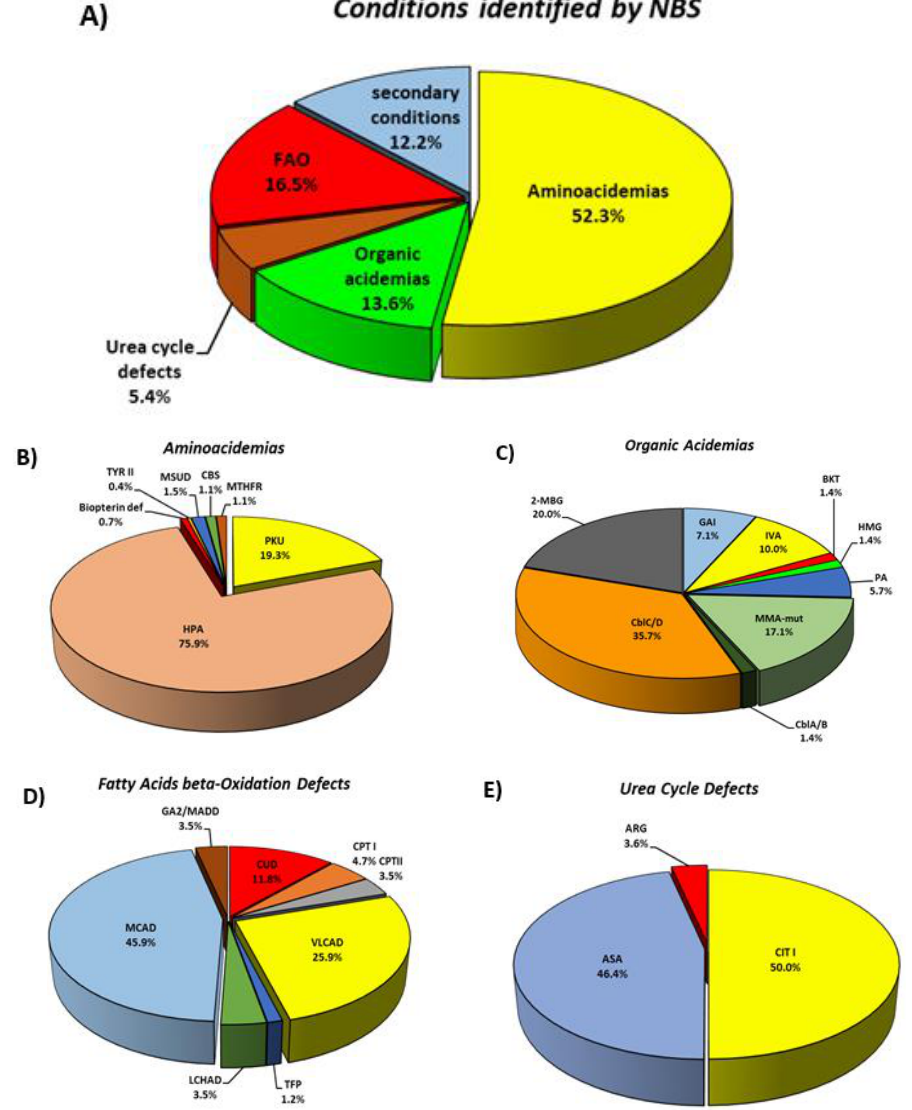
Figure 3. The percentage of different classes of inborn errors of metabolisms in the Italian neonatal population during years 2019–2020, ( A ). The distribution of the different conditions identified by Expanded Newborn Screening, ( B – E ).